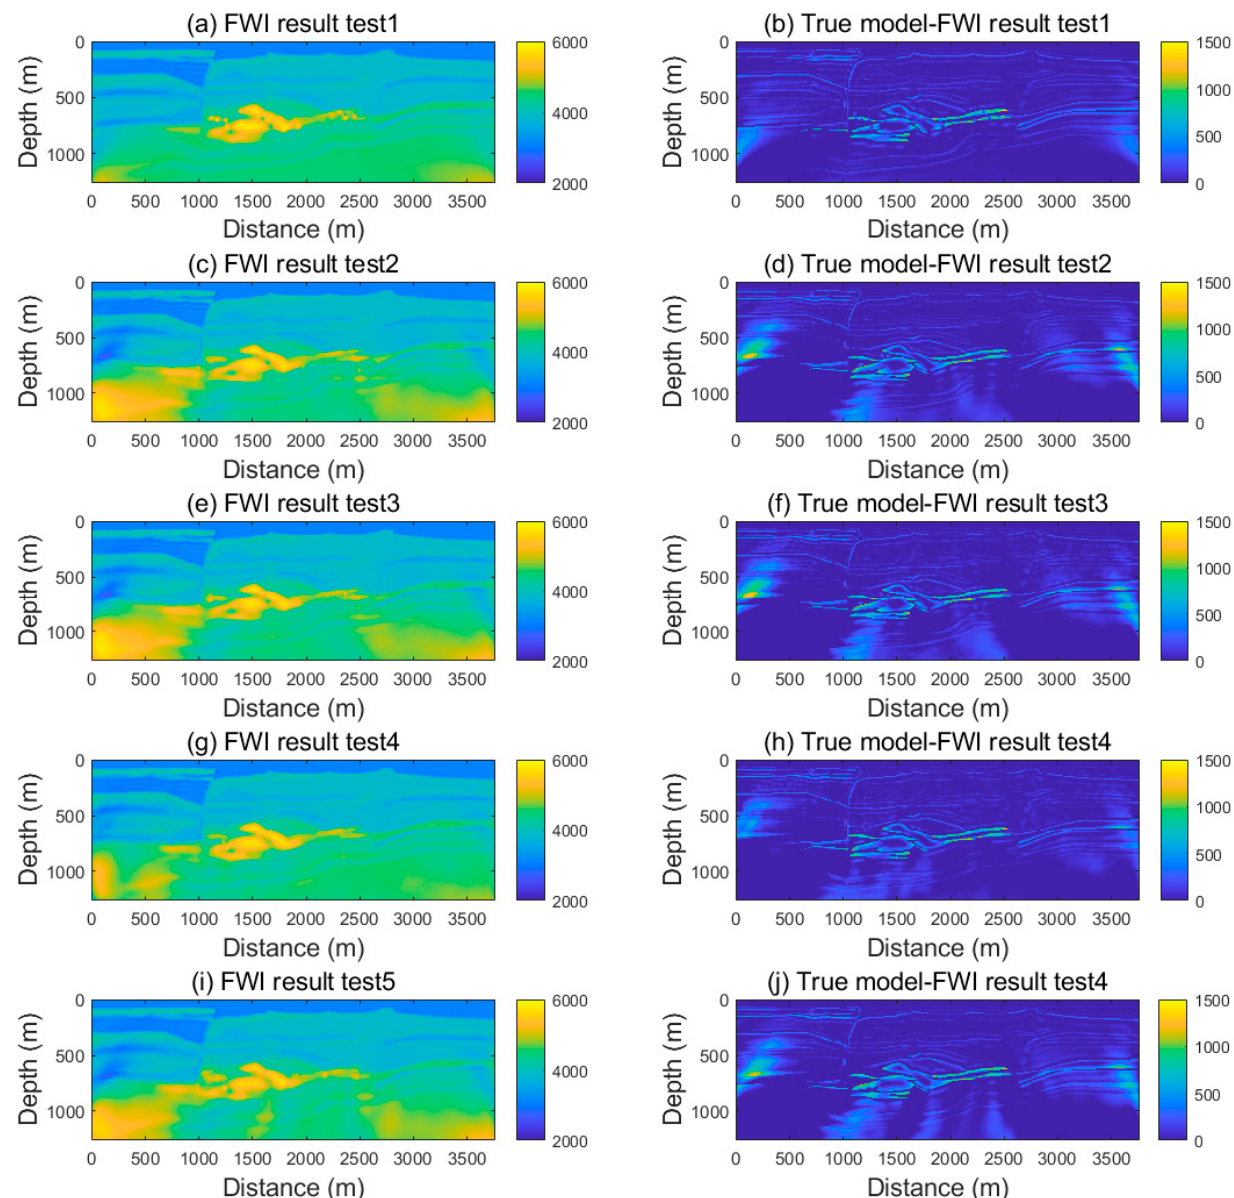
Figure 14. The comparison of the different multisource FWI tests. ( a , c , e , g , i ) are the final FWI results for tests 1–5; ( b , d , f , h , j ) are the differences between the final FWI results and the true model for tests 1–5.